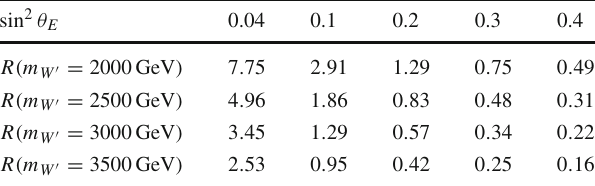
Fig. 4 The relative corrections of W (cid:2) in the NU model to the decay B − → γμ − ¯ ν μ as functions of sin 2 θ E with T 32 = 1 in the up-quark mixing scenario Table 5 The numerical results for the relative corrections of W (cid:2) pre- dicted by the NU model to the decay B − → γμ − ¯ ν μ with T 32 = 1 in the up-quark mixing scenario, in unit of 10 −